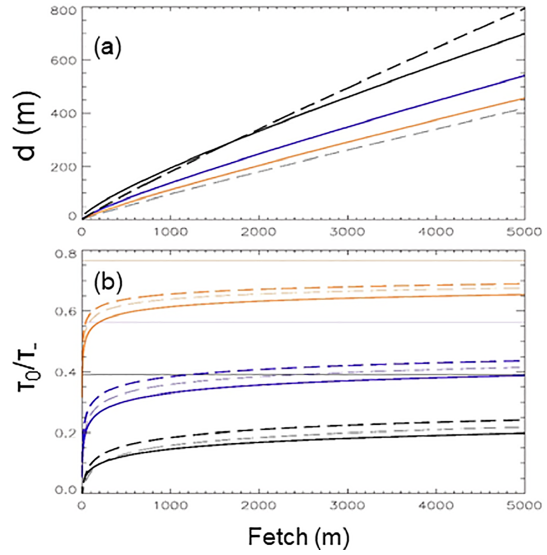
Figure 2. Theoretical IBL depths (a) and surface stress (b) as a function of fetch over water for a rough-to-smooth transition (off- shore flow) for forested landscapes (black curves, M = 6 . 9), shrub- land (blue curves, M = 4 . 6), and grassland (red curves, M = 2 . 3). Solid curves – Panofsky and Townsend (1964) approach; dashed curves – Jensen (1978) approach with A = 1 (thin dashed) and A = 2 (thick dashed). Surface stress values are normalized by the upstream value. Thin horizontal lines represent equilibrium down- stream values proposed by Jensen (1978) for downstream surface Rossby number Ro = 10 8